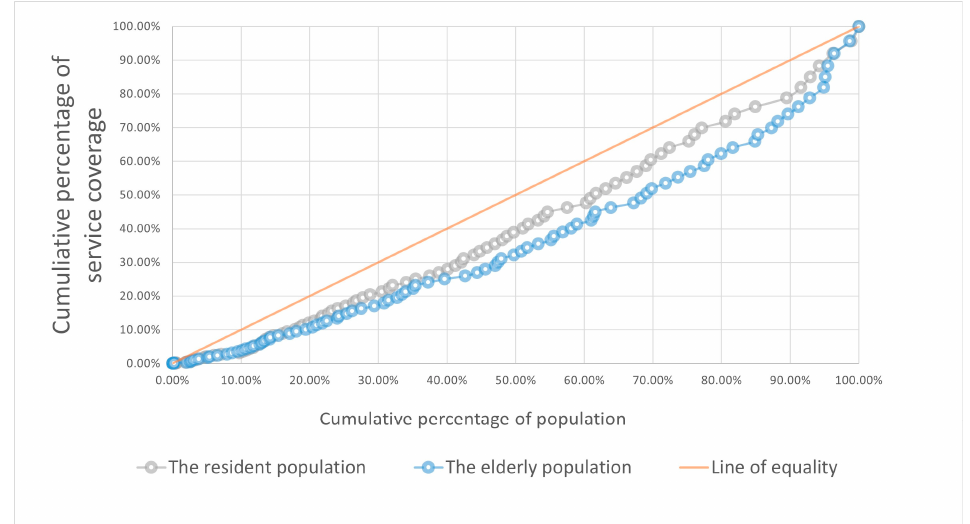
Figure 8. Lorenz curve by resident/elderly population.